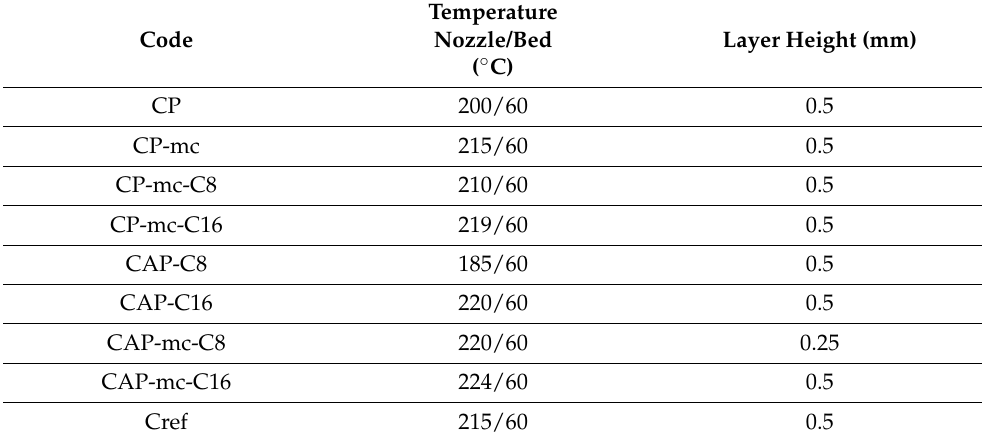
Table 7. Parameters used in 3D printing